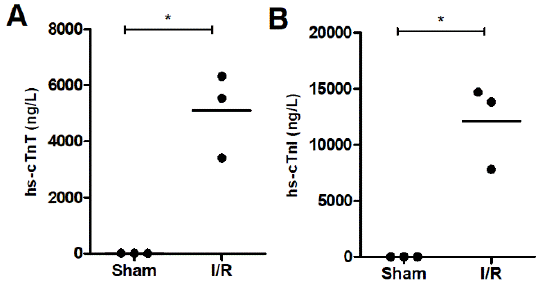
Figure 1. Cardiac troponin concentrations in circulating blood ( A , hs-cTnT and B , hs-cTnI) for sham and I/R rats illustrating significant heart injury in the I/R rats. The mean is represented by the line and * indicates p - value ≤ 0.005 .